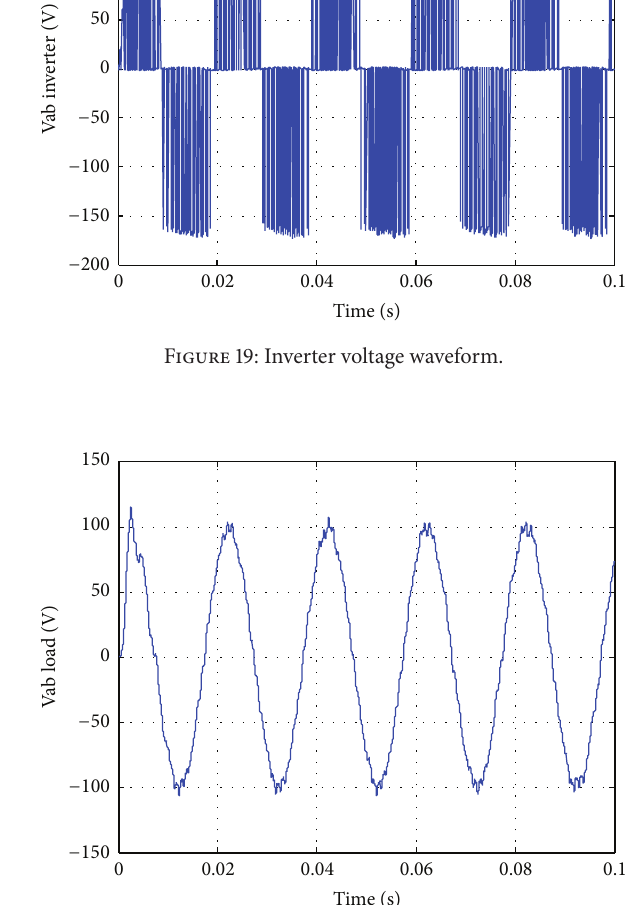
Figure 17: Load PV voltage waveform.